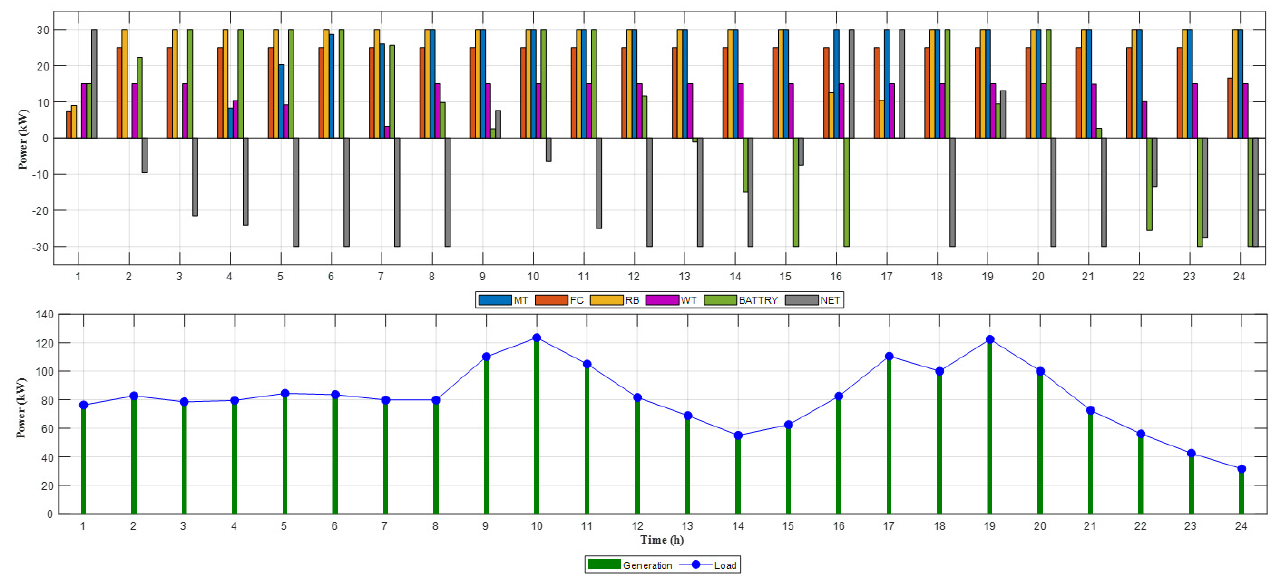
Figure 8. Optimal management of electrical elements of the micro-grid.